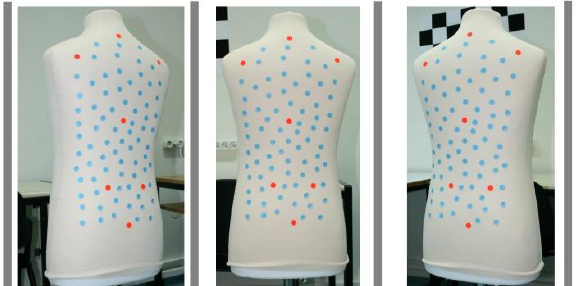
Figure 11 Photogrammetric processing images (left, centre,